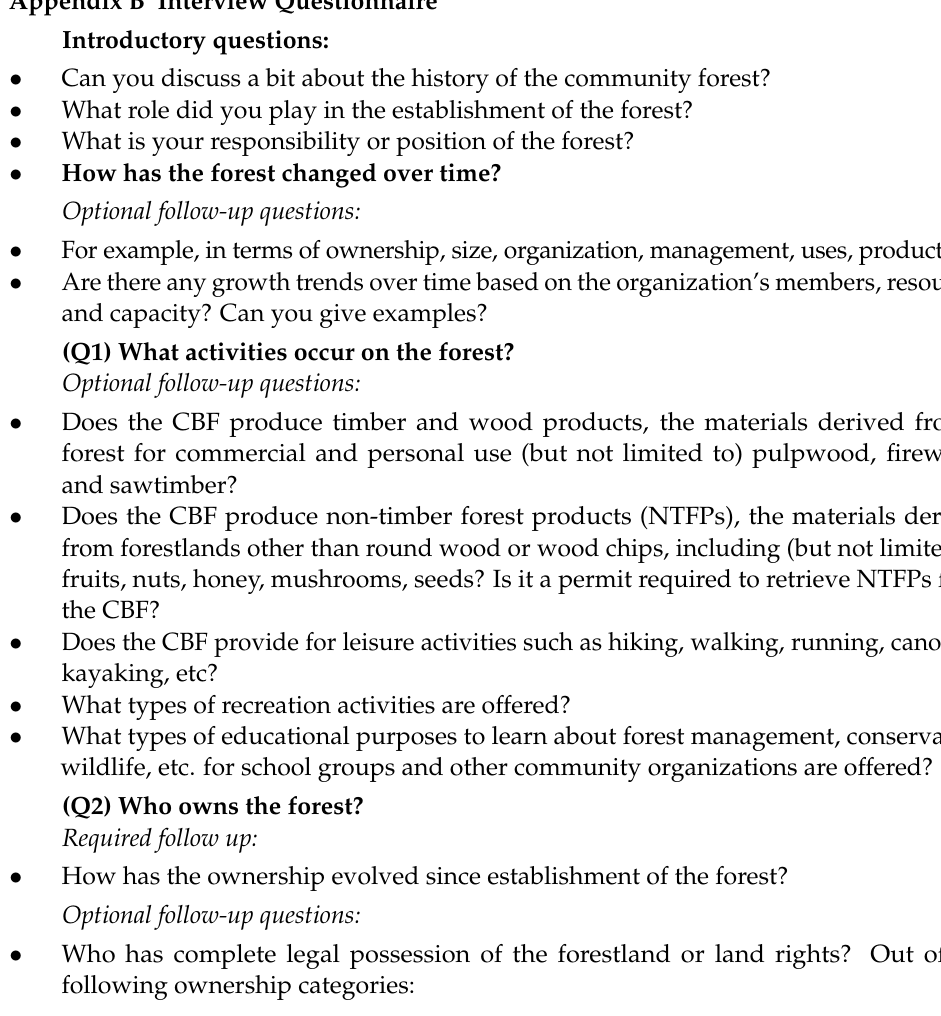
* Represents keywords that have been truncated, meaning the web-based search include words with various word endings or phrases. For example, “community forest” could also search for phrases like “community forestry” or “community